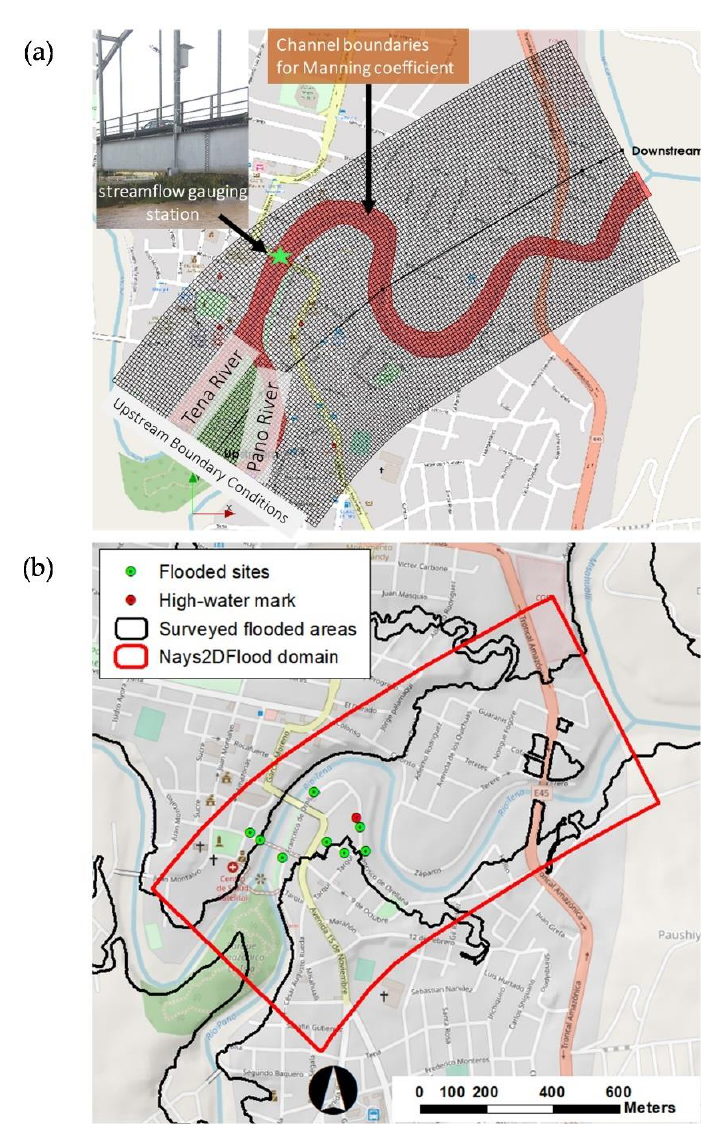
Figure 3. Hydrodynamic domain and control points for calibration and validation. ( a ) Modeling domain for the hydrodynamic simulations and location of the streamflow gauging station; ( b ) Polygon of flooded areas (black line), additional control points of flooded sites (greenish dots), and high-water mark (reddish dot) used to validate the results of the hydrodynamic model in simulating the 2017 flood event.